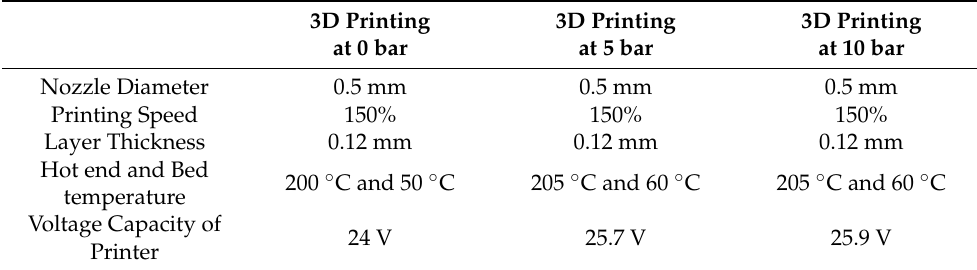
Table 1. 3D printer parameters while printing in